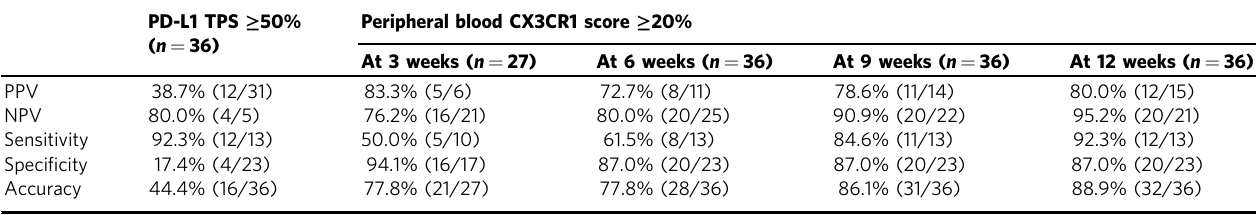
Table 1 Comparison of biomarker performance between PD-L1 TPS and the CX3CR1 score. PD-L1 TPS ≥